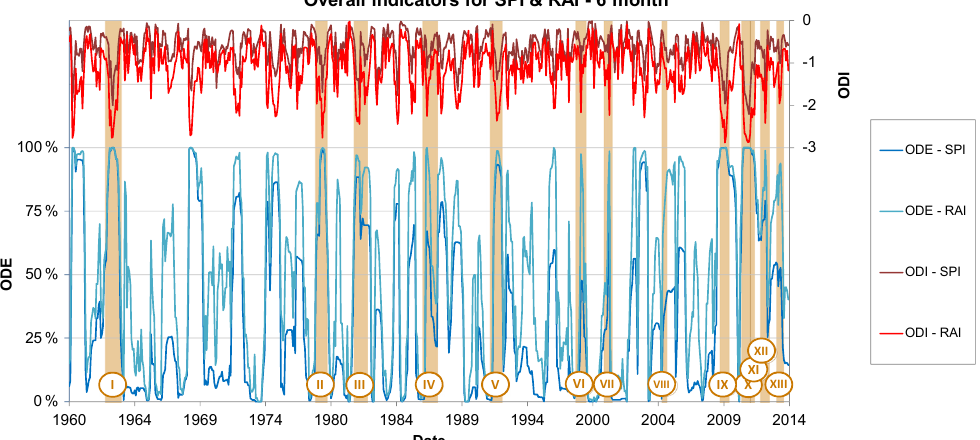
Figure A5. ODE and ODI values using the 6-month timescales of SPI and RAI indices, compared with the 13 detected historical droughts (in orange).